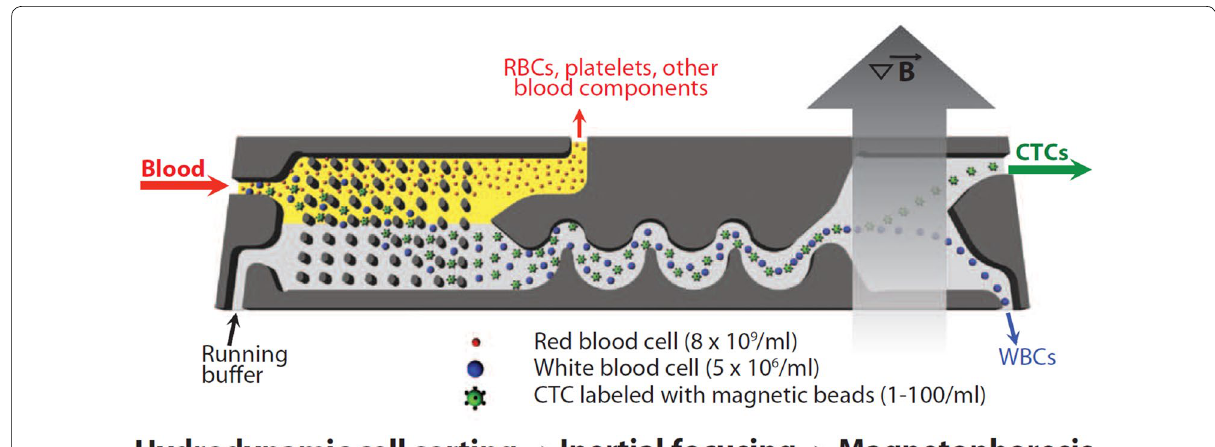
Fig. 1 CTC-iChip, developed by Ozkumur et al., capable of sorting rare CTCs from whole blood at 107 cells/s [47]. Schematic representation of three microfluidic comportments is shown. Immunomagnetically labeled whole blood and buffer are introduced into the first compartment via two input channels. In the first compartment, magnetically labeled CTCs and white blood cells are hydrodynamically sorted from the whole blood. Next, CTCs and WBCs are focused. Finally, a magnetic field (grey arrow) is applied to separate labeled CTCs and